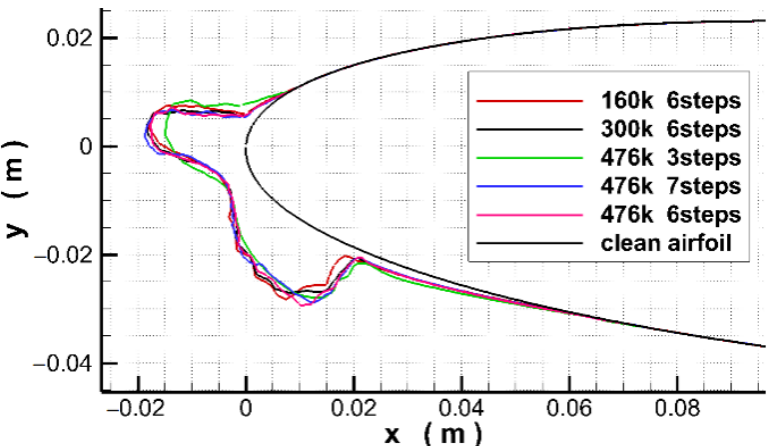
Figure 2. Calculated ice shapes at different grid numbers and icing steps.